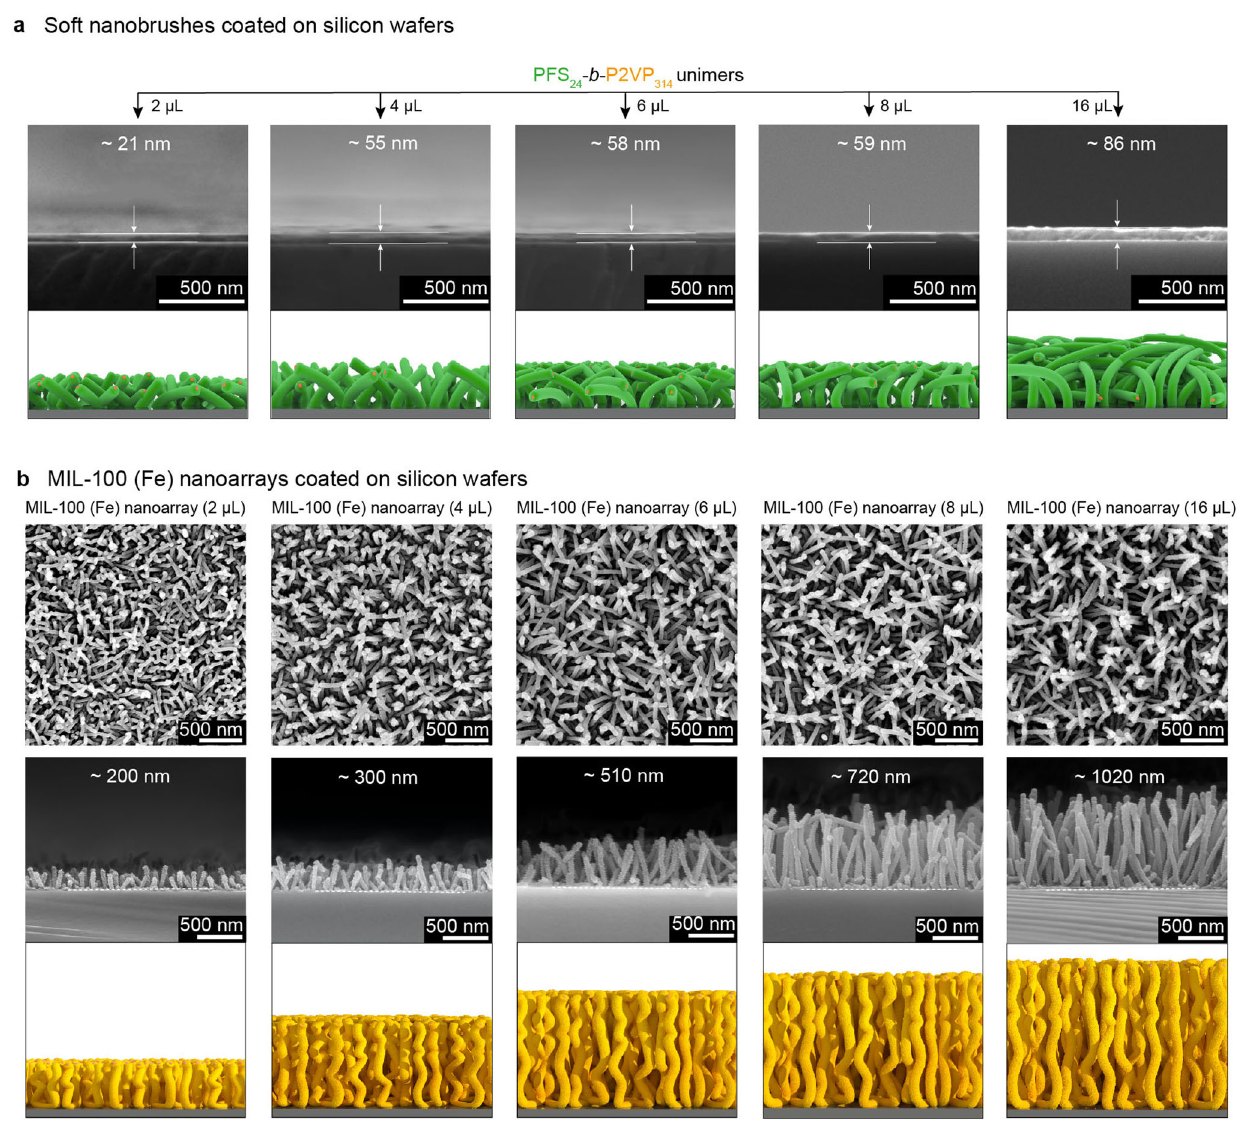
Fig. 3 | Height regulation of MIL-100 (Fe) nanoarrays. a Cross-sectional SEM imagesofsoftnanobrushesformedwiththeadditionof2,4,6,8and16 µ LofaTHF solution (10mg/mL) of PFS 24 - b -P2VP 314 unimers. b Top-view and